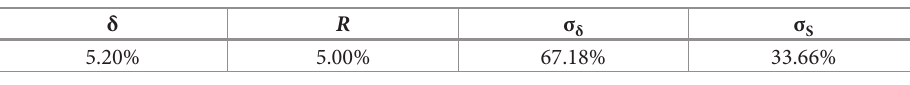
table 1. Parameters used in Real Options